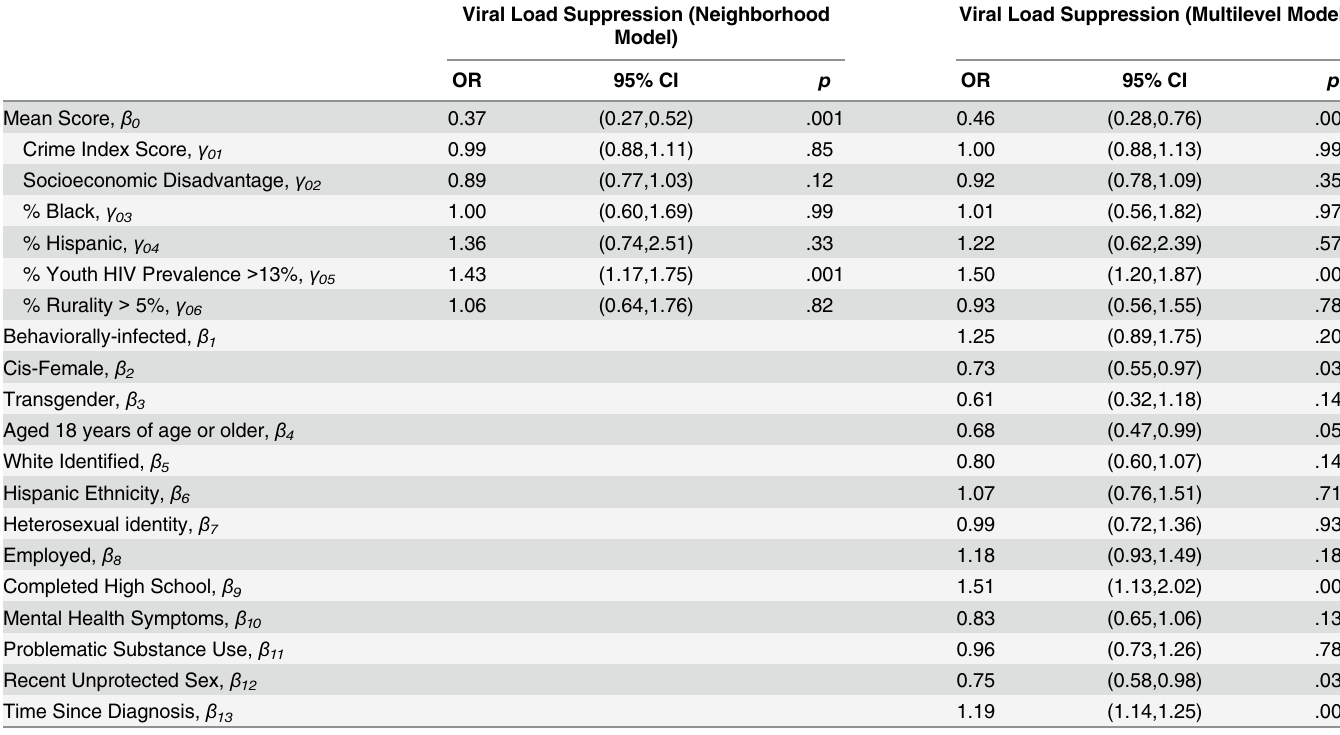
Table 5. Multi-level Associations between Viral Load Suppression and Structural- and Individual- Level